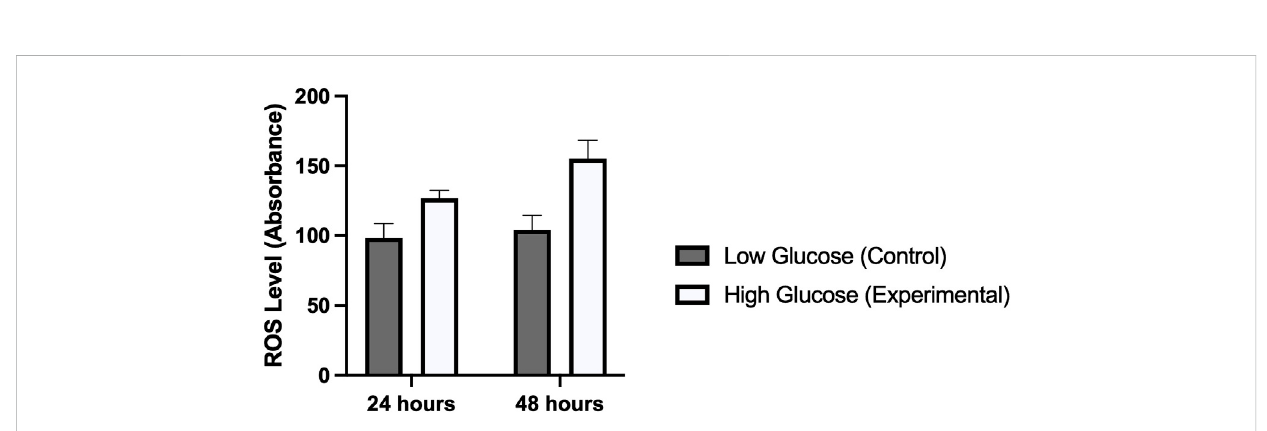
FIGURE 5 Shows the level of reactive oxygen species in HUVECs treated with normal/low glucose and high glucose concentrations for 24 and 48